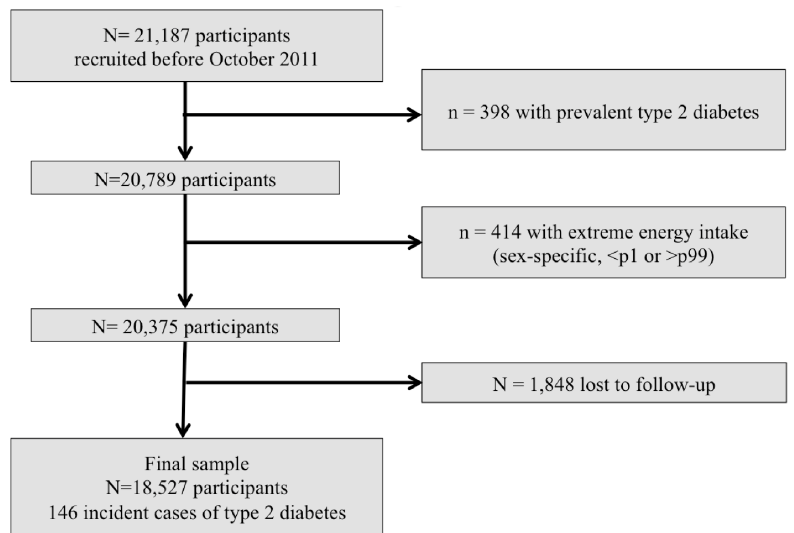
Fig 1. Flow-chart of participants. The SUN Project 1999 –